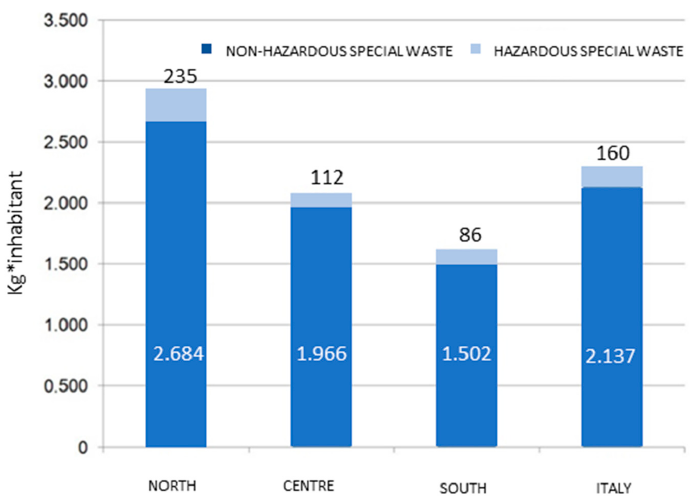
Figure 4. Special waste production in the main parts of Italy. Source: Own elaboration from ISPRA